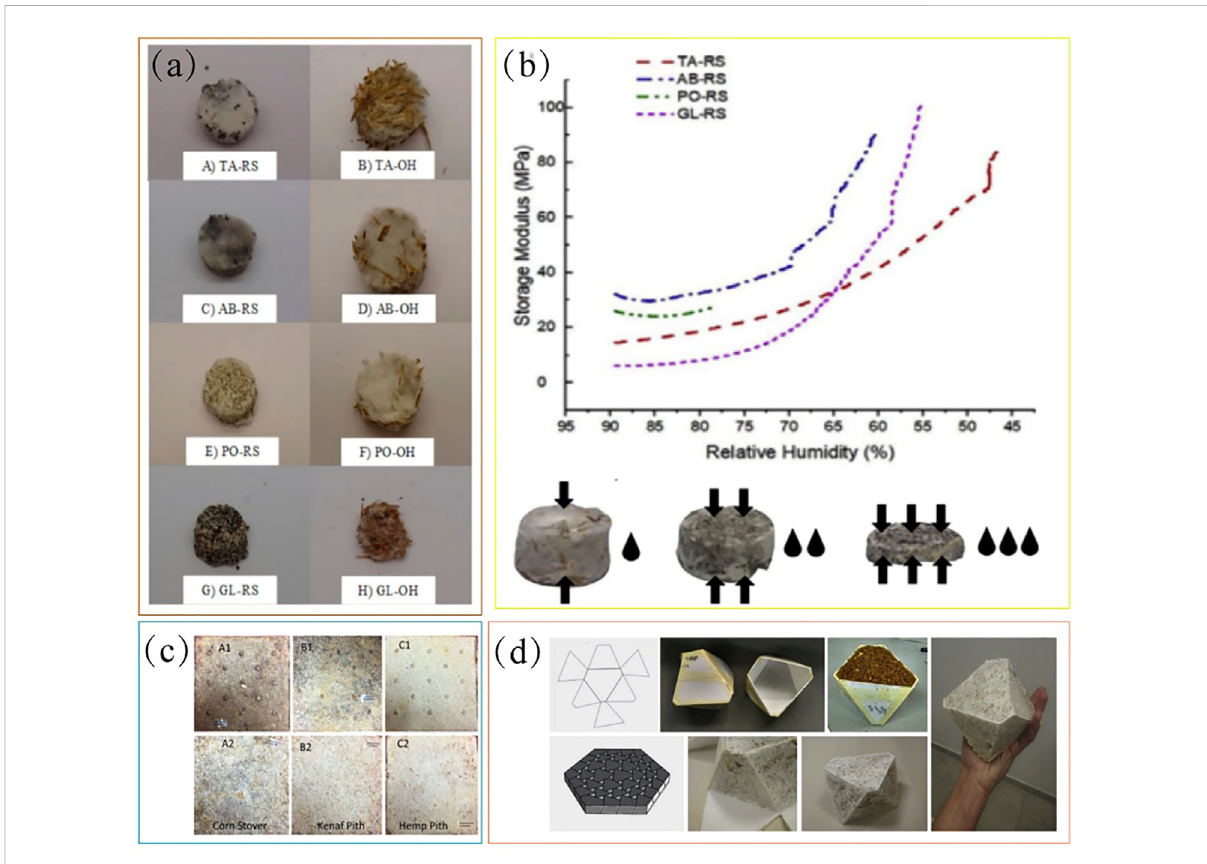
FIGURE 3 (A) Development of moisture-resistant composites based on different matrices ( Trichoderma asperellum (TA) grown on A) rapeseed cake (RS) and B) oat husks (OH) as substrates; Agaricus bisporus (AB) grown on C) RS and D) OH; Pleurotus ostreatus (PO) grown on E) RS and F) OH; Ganoderma lucidum (GL) grown on G) RS and H) OH), (B) their dynamic moisture monitoring and schematic diagram of material changes (Tacer- Caba et al., 2020), (C) development of termite-resistant composite bio-boards (Bajwa et al., 2017), (D) speci fi c models constructed based on CAD design and innovative molds (Attias et al.,